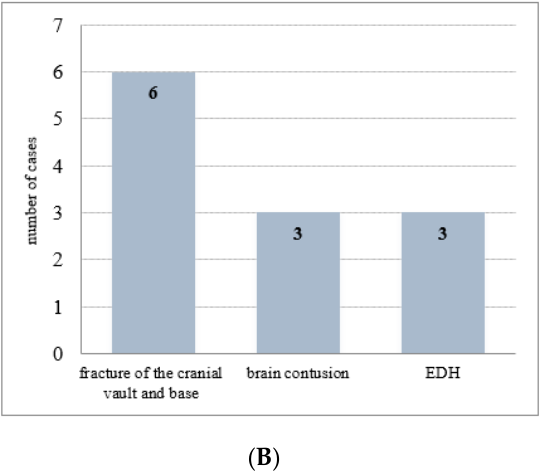
Figure 1. ( A ) The false negative cases of CT scans (61) for each type of injury. SAH—subarachnoid hemorrhage; SDH—subdural hemorrhage; EDH—epidural hemorrhage; IVH—intraventricular hemorrhage. ( B ) The false positive cases of CT scans (12) for each type of injury. EDH—epidural hemorrhage.